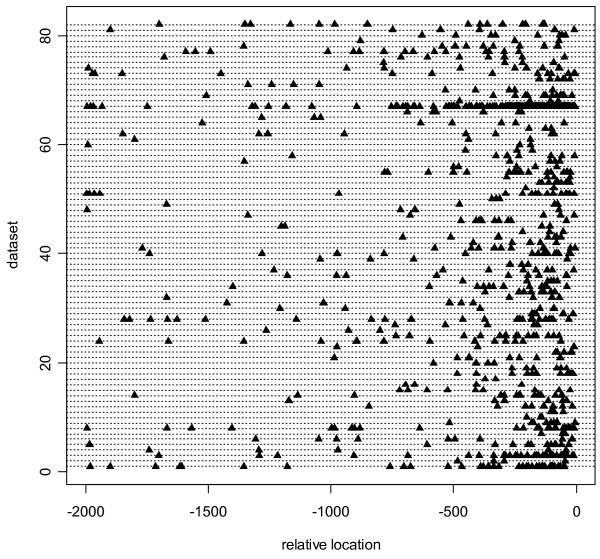
Distribution of known locations of binding site in TRANSFAC dataset. The x-axis is anchored on the TSS, denoted as location 0. All sequences in each test subset are collapsed into a single line; hence the 82 data subsets are shown as 82 different horizontal lines. Each data subset contains TFBSs corresponding to a single specific transcription factor.